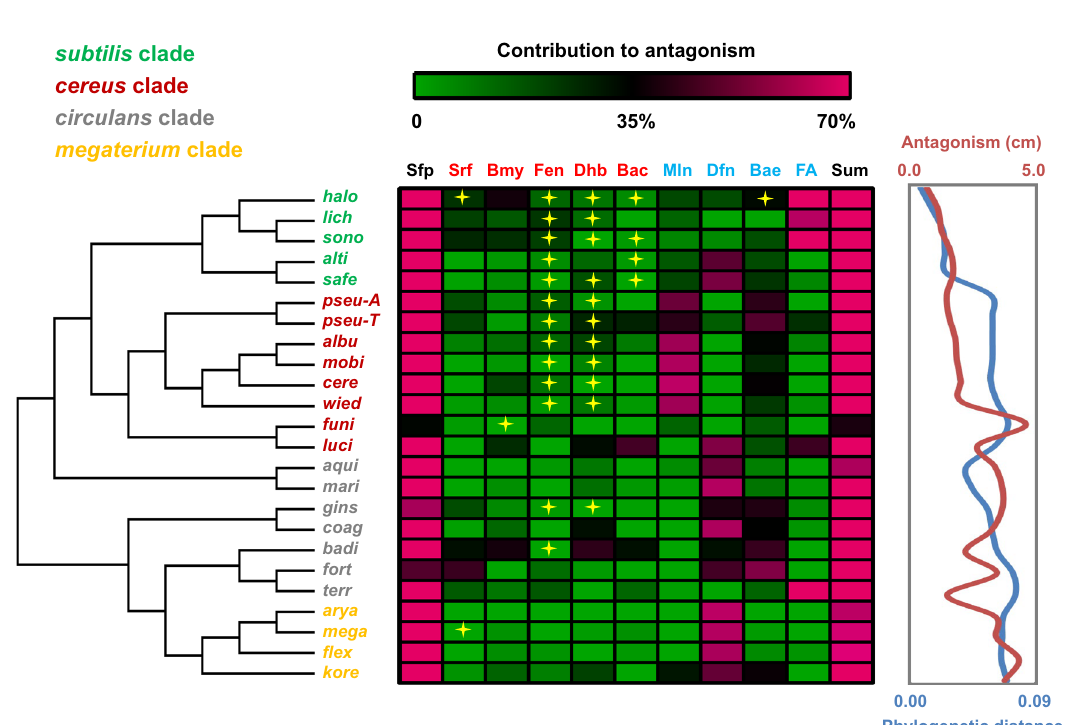
0.00 Fig. 5 Contribution of BGCs to antagonizing Bacillus species from different clades by B . velezensis SQR9. The heatmap shows the contribution of each BGC product (on the top) to the inhibition of each target strain (on the left), which was calculated as the percentage of the decreased inhibition zone of the corresponding BGC-de fi cient mutant compared with wild-type. The maximum likelihood (ML) tree on the left was constructed based on the 16 S rRNA sequences of the 24 target strains: halo B. halotolerans CF7, lich B. licheniformis LY2, sono B. sonorensis YX13, alti B. altitudinis LY37, safe B. safensis LY9, pseu -A B. pseudomycoides ACCC10238, pseu -B B. pseudomycoides TZ8, albu B. albus XL388, mobi B. mobilis XL40, cere B. cereus ACCC10263, wied B. wiedmannii CF23, funi B. funiculus ACCC05674, luci B. luciferensis XL165, aqui B. aquimaris XL39, mari B. maris fl avi XL37, gins B. ginsengihumi ACCC05679, coag B. coagulans ACCC10229, badi B. badius ACCC60106, fort B. fortis ACCC10219, terr B. terrae TL19, arya B. aryabhattai XL26, mega B. megaterium ACCC01509, fl ex B. fl exus DY11, kore B. koreensis ACCC05681. The abbreviations on the top (except Sfp) represent different BGC products: Srf surfactin, Bmy bacillomycin D, Fen fengycin, Dhb bacillibactin, Bac bacilysin, Mln macrolactin, Bae bacillaene, Dfn dif fi cidin, FA an antimicrobial fatty acid, bacillunoic acid. Speci fi cally, Sfp (phospho-pantheinyltransferase) is not an antibiotic but is necessary for modi fi cation of the above antibiotics and ensuring their activity, except for bacilysin 22,30 ; here, the contribution of Sfp to antagonism means the relative reduction of inhibition by SQR9 Δ sfp compared to that of wild-type SQR9 towards different targets. “ Sum ” represents the overall contribution of the nine BGCs (excludes Sfp) to the antagonism against different targets. The cross represents the BGCs presence in the testing strains based on their genomic information, or for the non-sequenced strains if more than 80% of the corresponding Bacillus species genomes possessed the cluster. The curves in the right box show the antagonistic phenotype and phylogenetic distance of B. velezensis SQR9 with each of the target strains. Each inhibition assay included six biological replicates and the average contribution was shown in the heatmap. Source data are provided as a Source Data fi